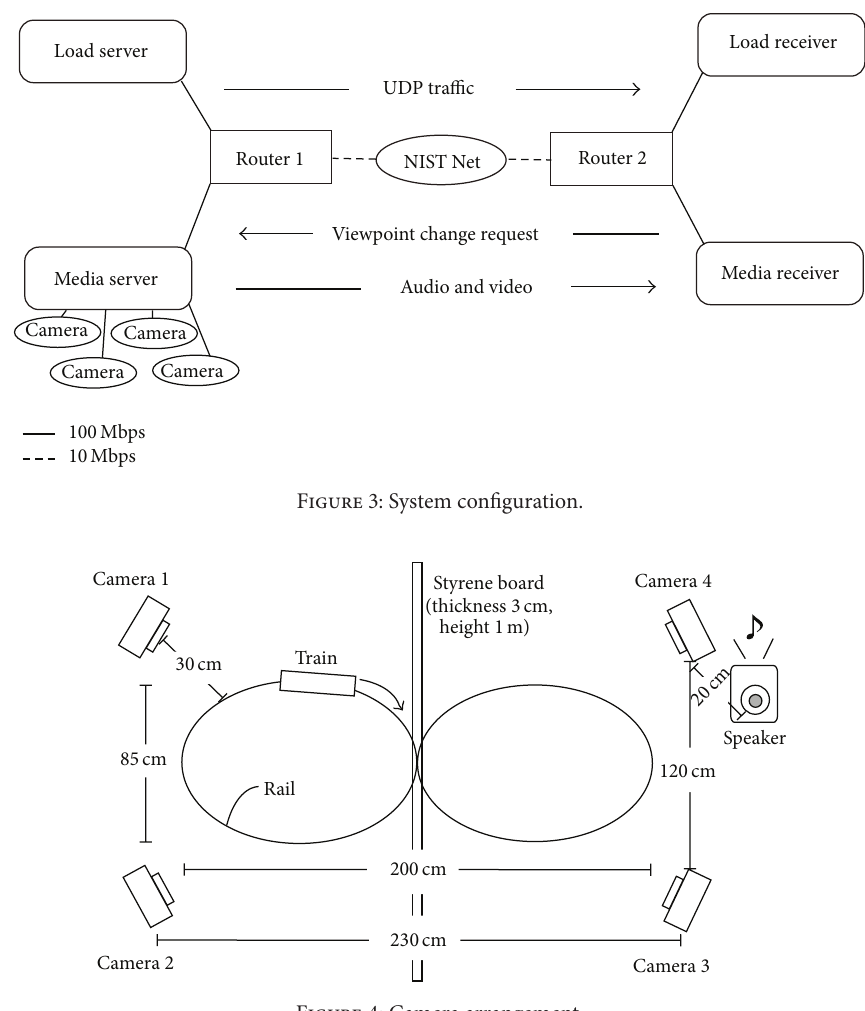
Figure 4: Camera